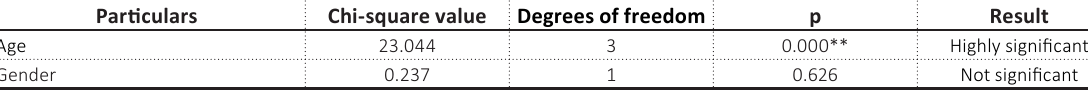
Table 5. Association between demographics and inclination to wait